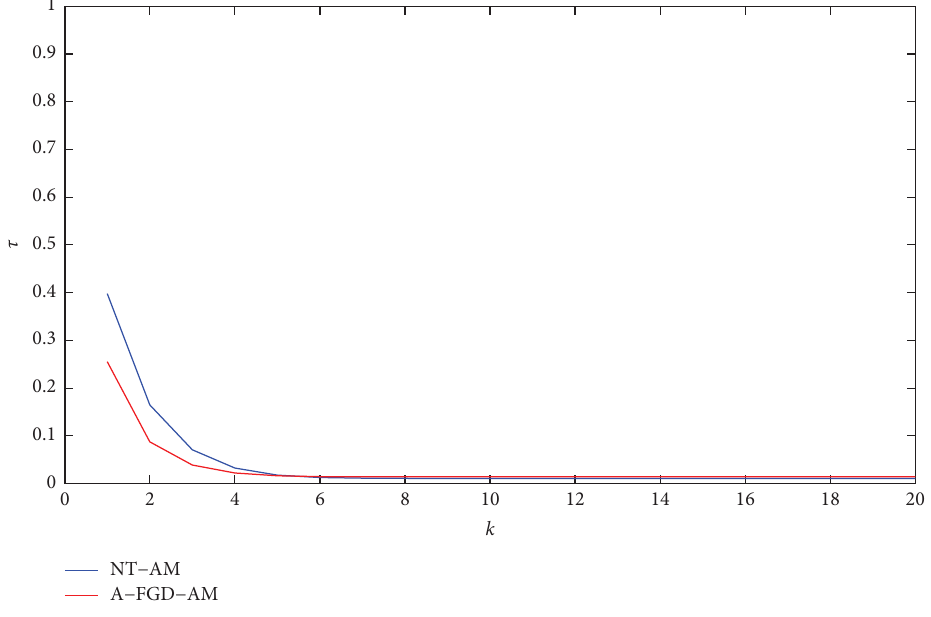
Figure 10: Te parameter estimation errors.